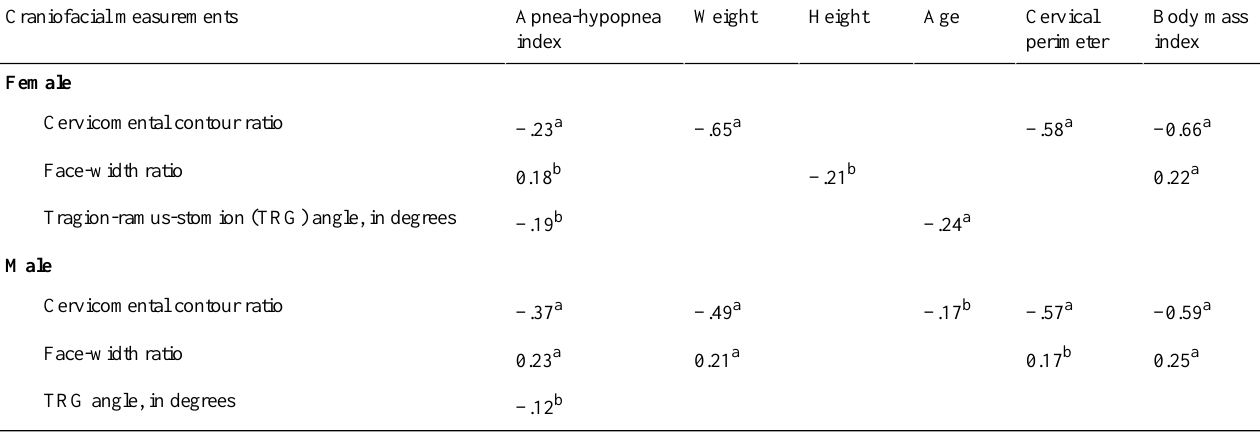
a Correlation is significant at the .01 level (two-tailed). b Correlation is significant at the .05 level